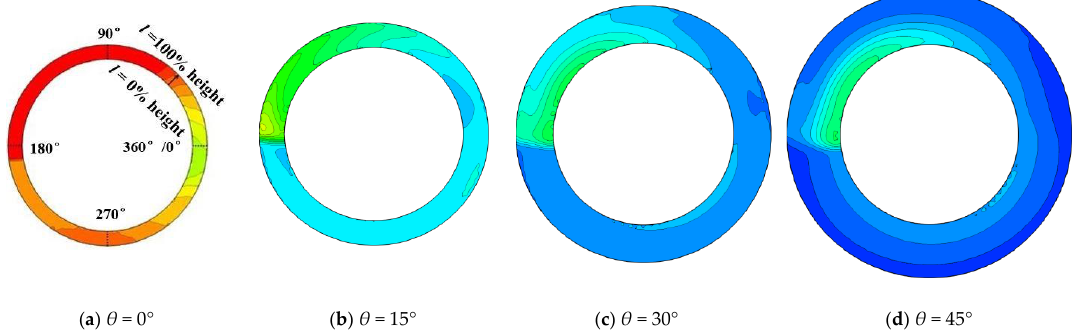
Figure 14. The outlet static pressure contour of the RDC with different θ at t = 3980 μs.